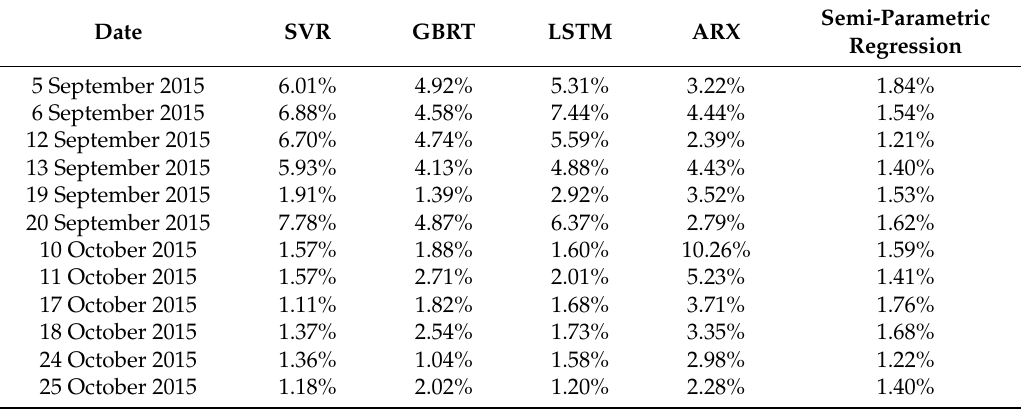
Table 4. Mean absolute percentage errors (MAPE) of Weekend Load Curve Forecast Results